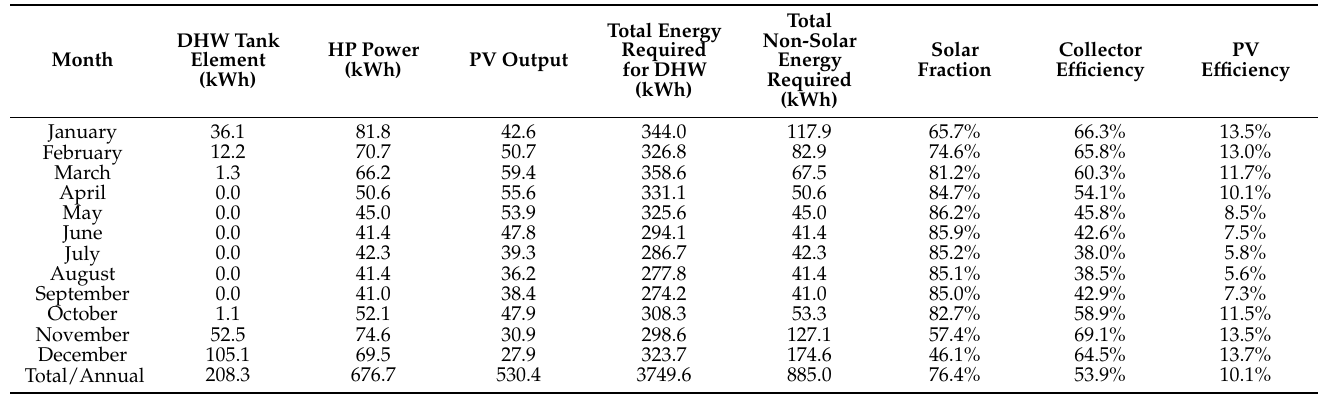
Table 12. MCPVT-HP system simulation results for Toronto with 45-degree tilt angle.